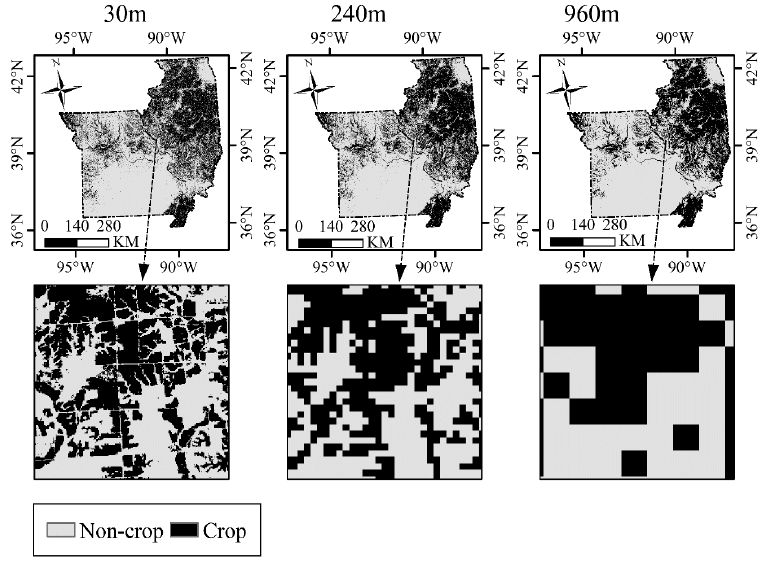
Figure 3. The crop/non-crop base map generated from Cropland Data Layer (CDL) data and the related upscaled maps for the Heartland region study area.